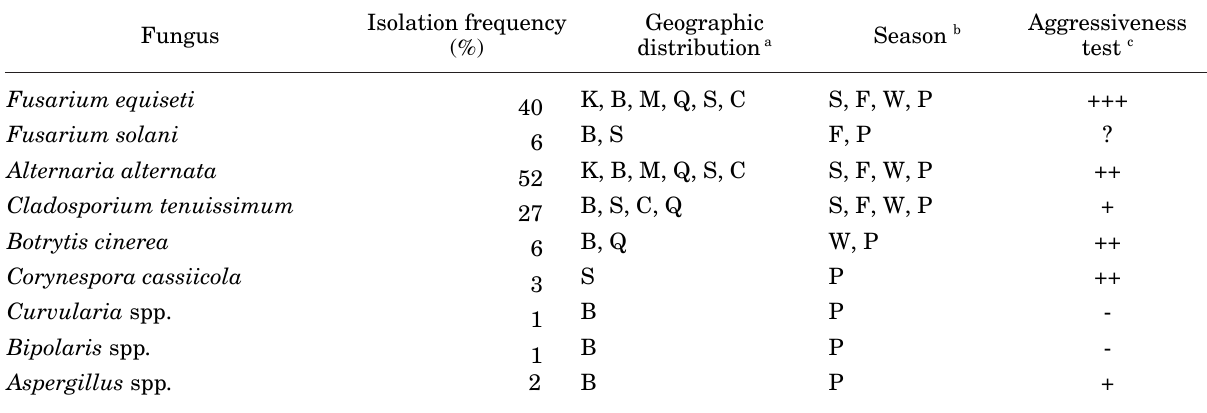
Table 2. Frequency of isolation and aggressiveness level of different fungi on immature cucumber fruits.